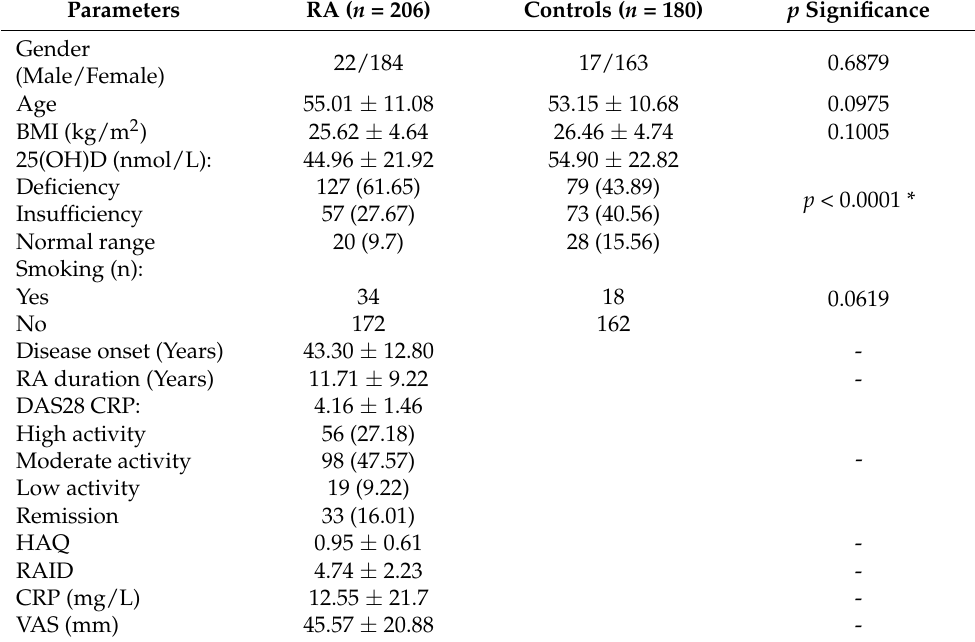
Table 1. Demographical, clinical, and biochemical characteristics of rheumatoid arthritis (RA) patients and